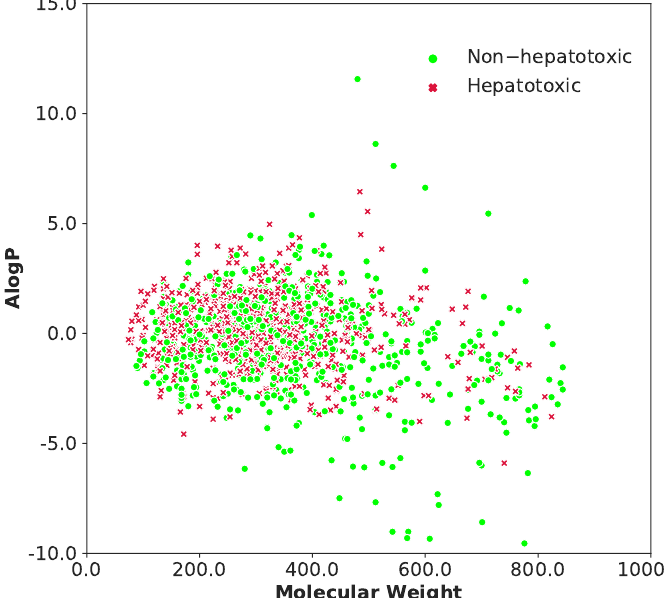
Figure 6. Chemical space defined by molecular weight and AlogP of the entire dataset (training and test datasets). Red x markers represent the hepatotoxic compounds and the green circle markers represent the non-hepatotoxic